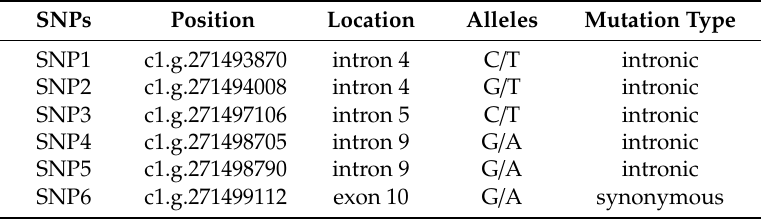
Table 2. Position and mutation types of detected single nucleotide polymorphisms